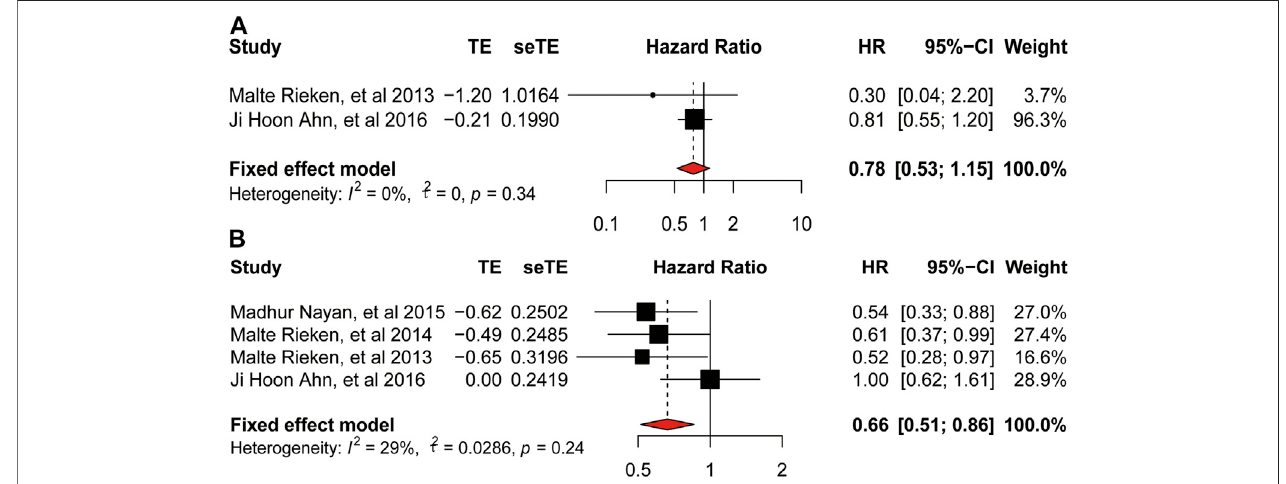
FIGURE 5 | Forest plot of hazard ratio for progression-free-survival and recurrence-free-survival. (A) Association between use of metformin and PFS of bladder cancer. (B) Association between use of metformin and RFS of bladder cancer.